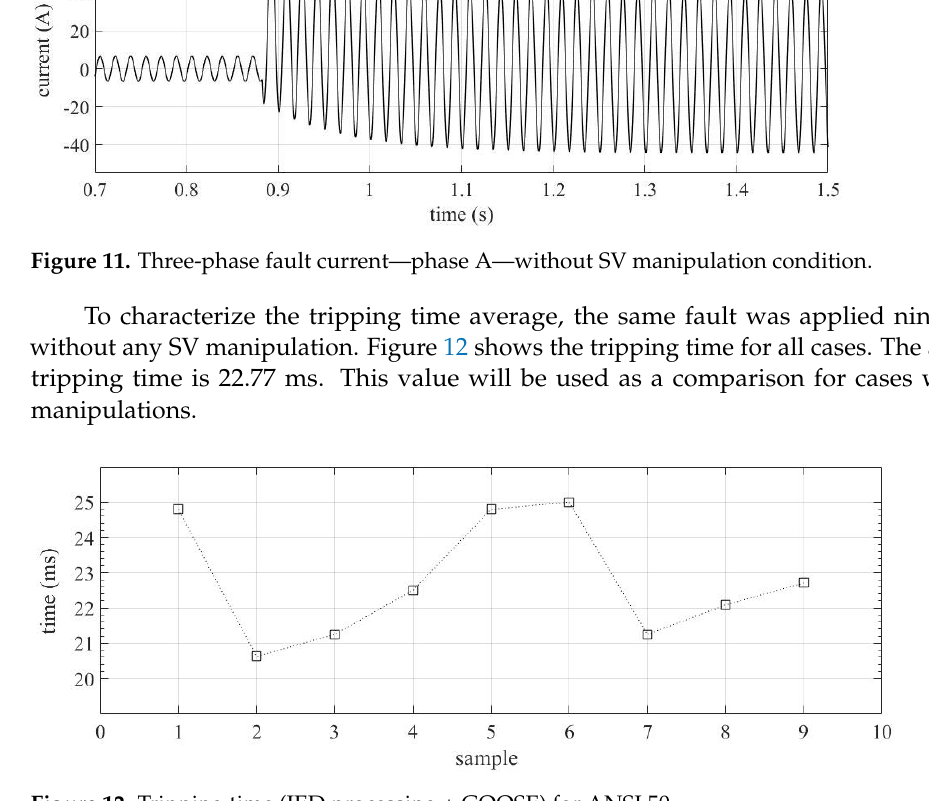
Figure 12. Tripping time (IED processing + GOOSE) for ANSI 50.